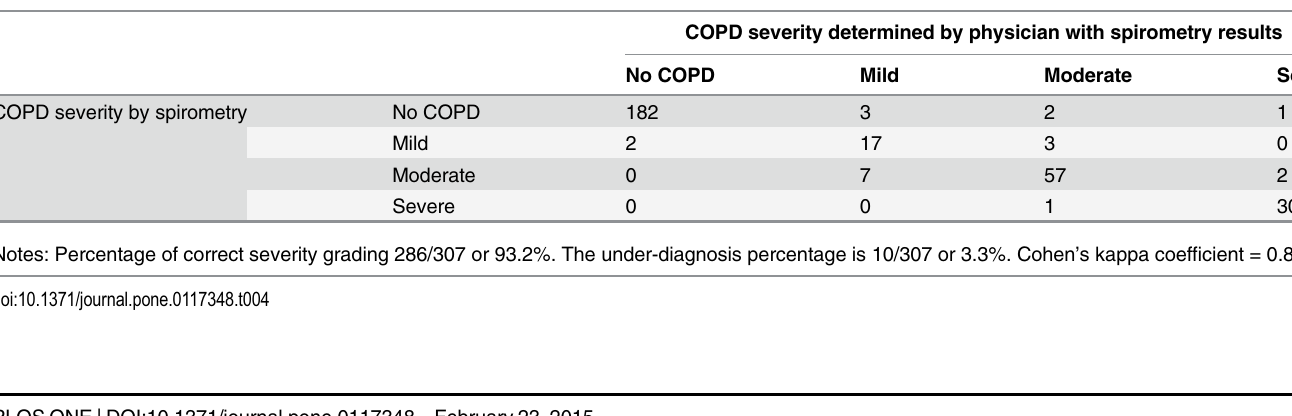
in the 307 patients. Without spirometry information, physicians correctly graded COPD sever- ity in 58.6% of subjects they identified as having COPD (Cohen ’ s kappa coefficient = 0.29). With spirometry information, this increased to 93.2% (Cohen ’ s kappa coefficient = 0.88).